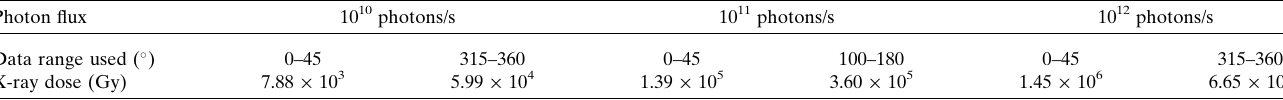
Table 1 The final data sets derived from data collected at increasing photon flux on Ls AA9_A(f) crystals. The 7.88 (cid:2) 10 3 Gy data set consists of the first 45 (cid:3) of the collection at 10 10 photons/s. The 5.99 (cid:2) 10 4 Gy data set consists of the last 45 (cid:3) of the collection at 10 10 photons/s. The 1.39 (cid:2) 10 5 Gy data set consists of the first 45 (cid:3) of the 10 11 photons/s collection. The 3.60 (cid:2) 10 5 Gy data sets consists of images in the range 100–180 (cid:3) of the 10 11 photons/s collection. The 1.45 (cid:2) 10 6 Gy data sets consists of the first 45 (cid:3) of the 10 12 photons/s collection. Finally, the 6.65 (cid:2) 10 6 Gy data set is from the last 45 (cid:3) of the 10 12 photons/s collection. Photon flux 10 10 photons/s 10 11 photons/s 10 12 photons/s Data range used ( (cid:3)